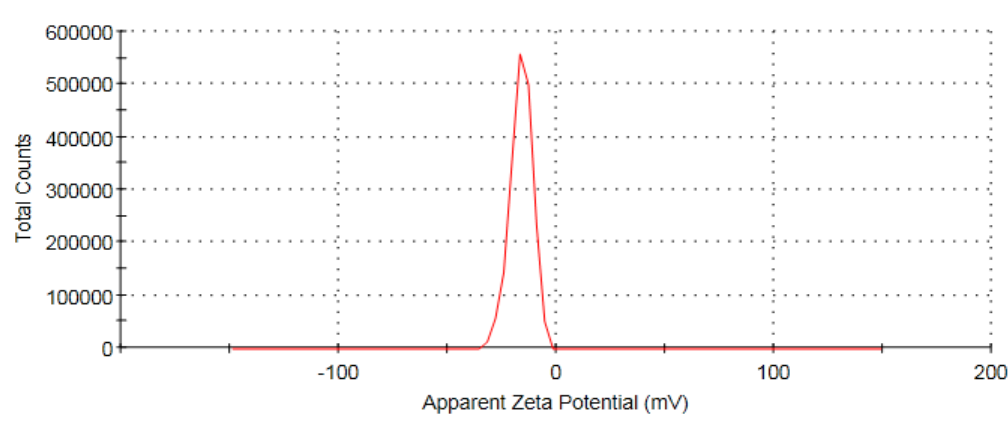
Figure 10. Zeta potential analysis of the biogenic silver nanomaterials.